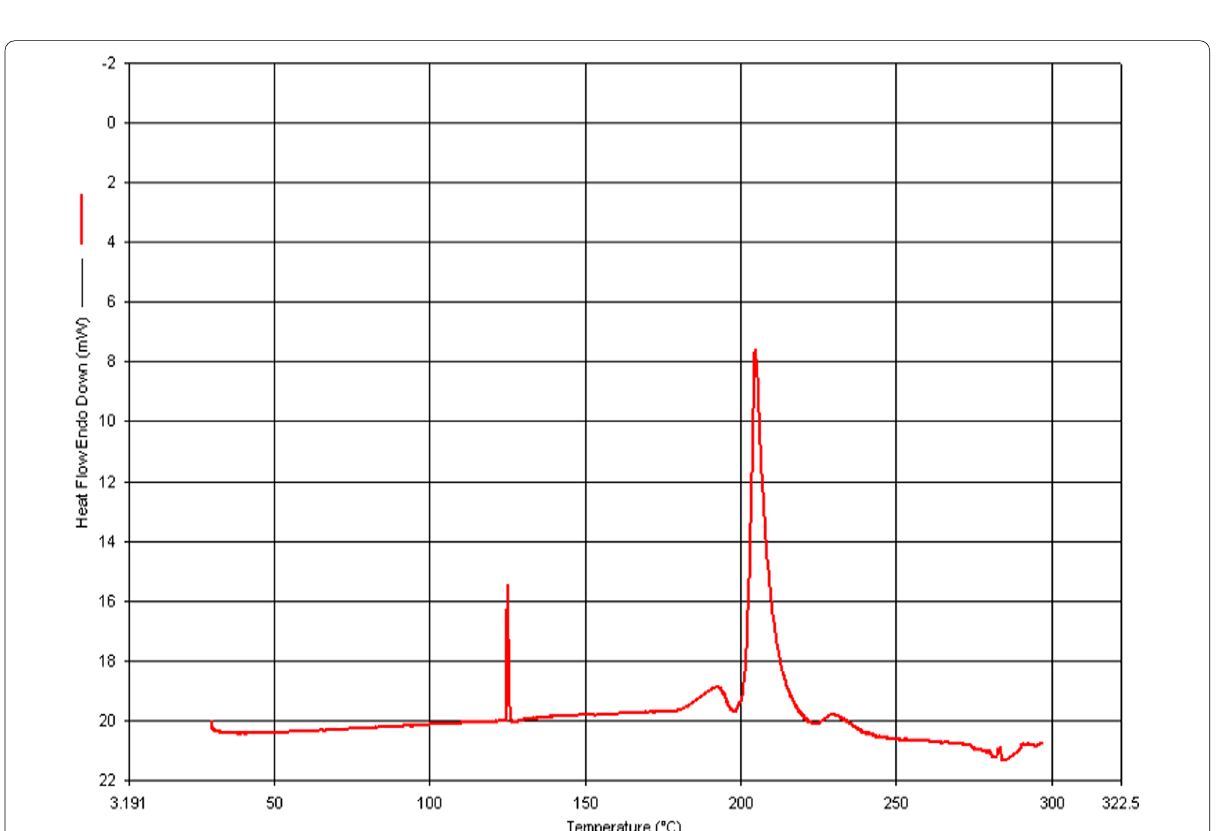
Fig. 2 DSC graph of